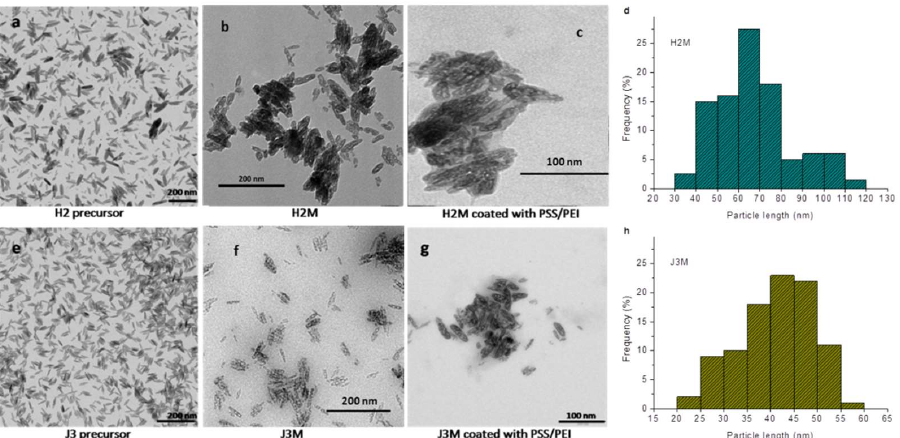
(MNRs) ( b , f ), and the polymer coated MNRs ( c , g ). Length histograms obtained from the TEM